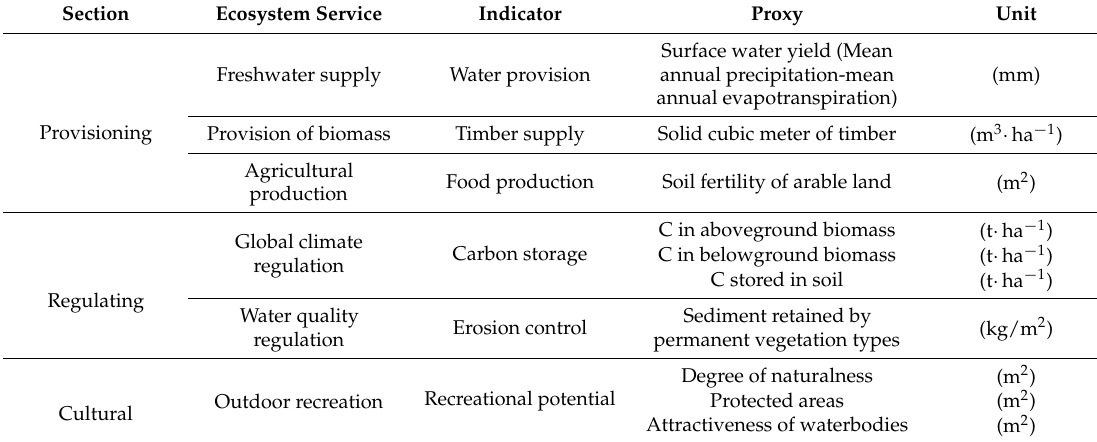
Table 1. Ecosystem services, biophysical indicators and corresponding proxies used for ecosystem service assessment in the study areas Vogelsberg and Wetterau,